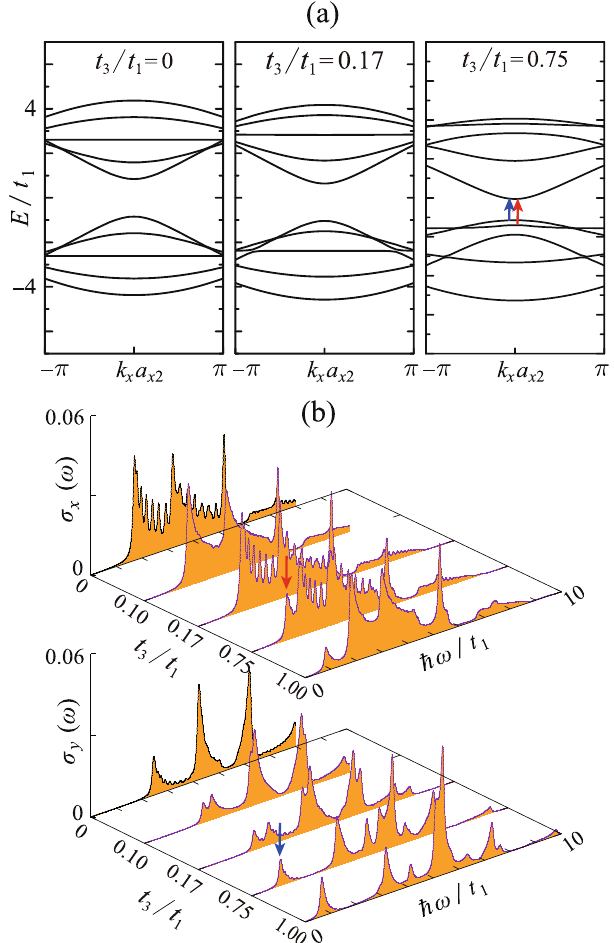
Figure 10. Same as Fig. 5, but for the case of 5a-Q1D-PNR. The lowest-lying absorption peaks and the corresponding interband transitions are illustrated by red ( x -polarization) and blue ( y -polarization)